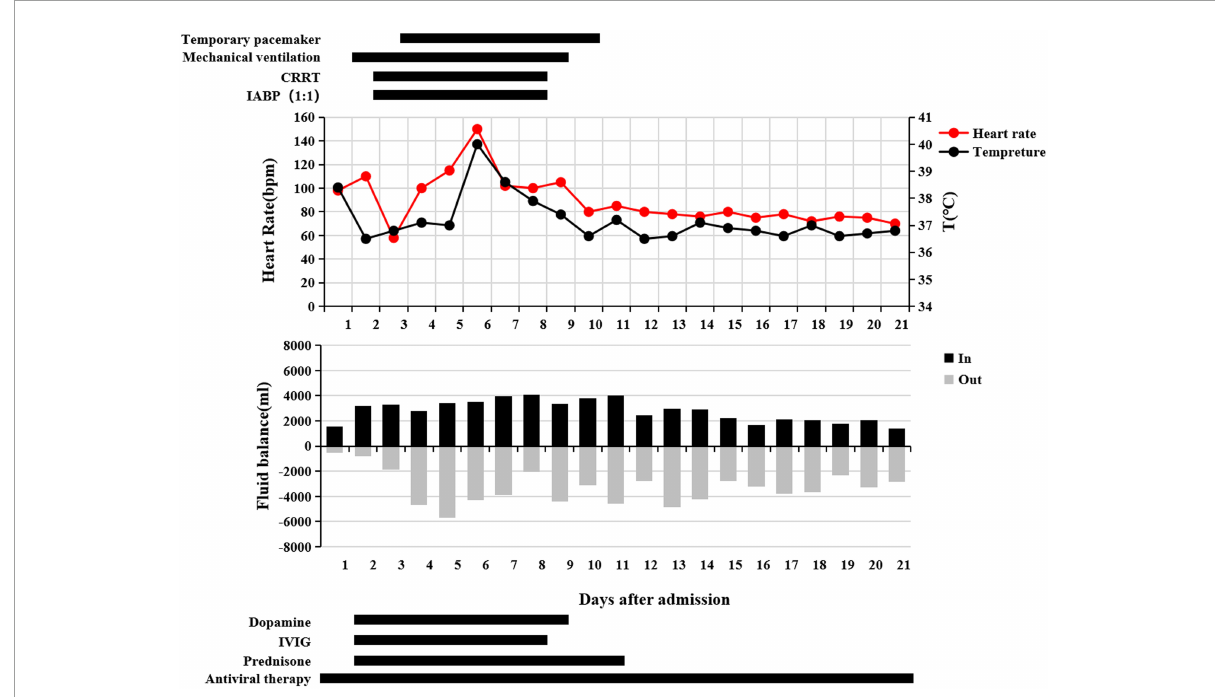
FIGURE3 Clinical course of the patient during 21 days of hospitalization. Heart rate and body temperature changes. Daily liquid inflow and outflow. Use mechanical support therapy and medication.